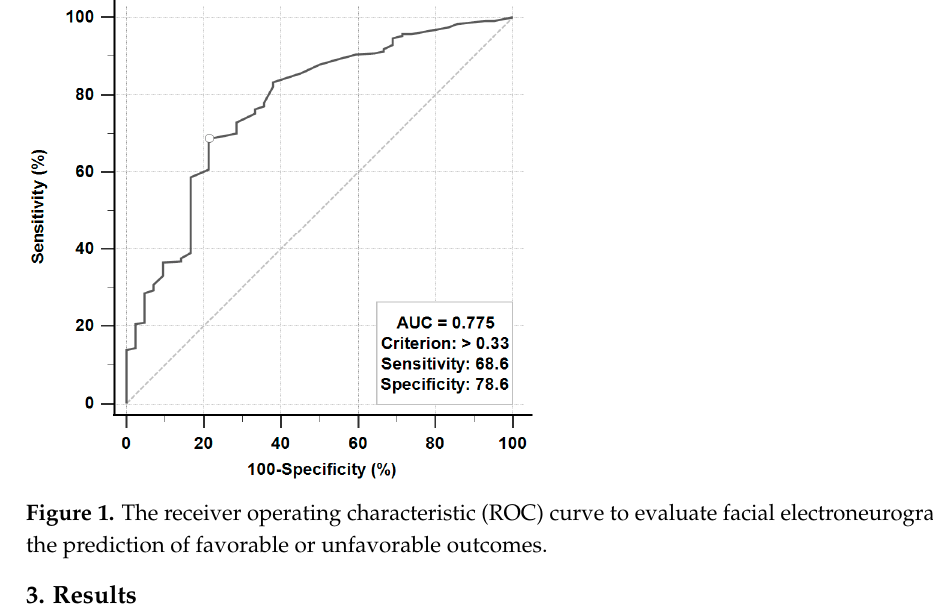
Table 1. Demographic and clinical variables of the patients with idiopathic Bell’s